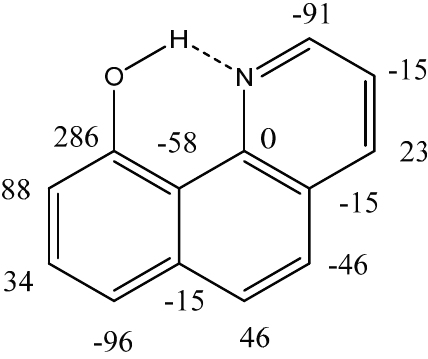
Figure 9. Deuterium isotope effects on 13 C chemical shifts in 10-hydroxybenzo[h]quinolone.